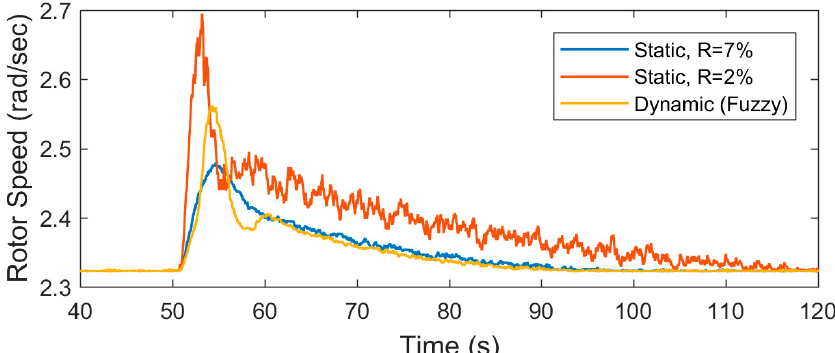
Figure 13. Dynamic droop (small ROCOF).